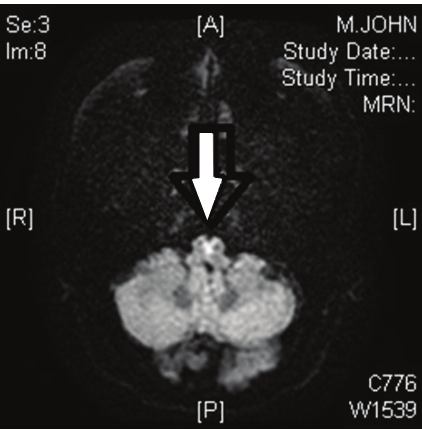
Figure 1: MRI of brain and DWI at presentation. Abnormal signal at DWI, a midline dot-linear signal, was similar to an artifact.